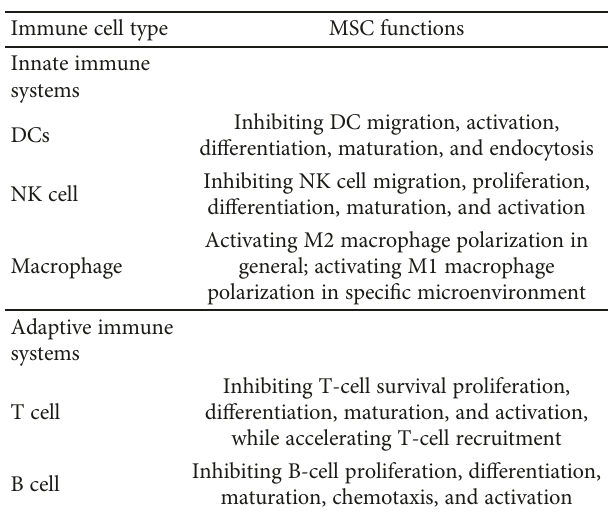
Table 1: The function of MSCs in mediating immune cells both in innate and adaptive immune